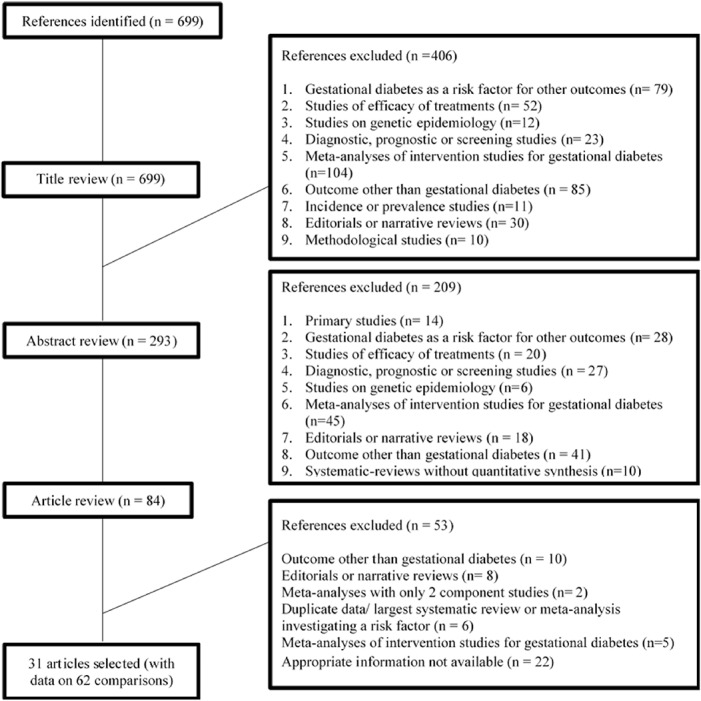
Flow diagram for the selection of included articles.